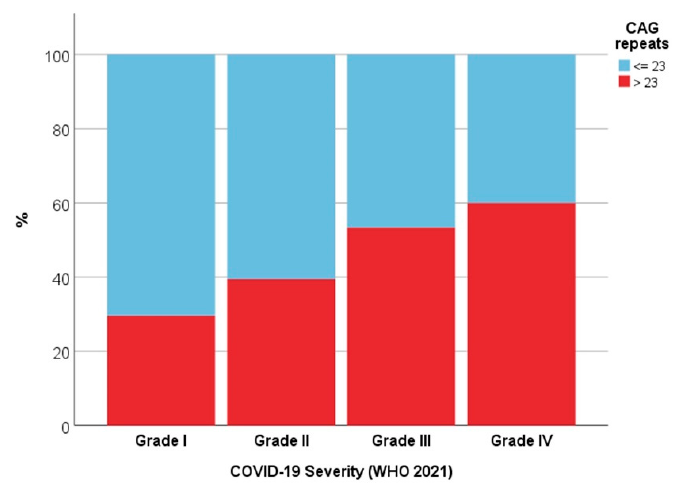
Figure 3. Number of CAG repeats in COVID-19 survivors, according to disease severity (4 grades,